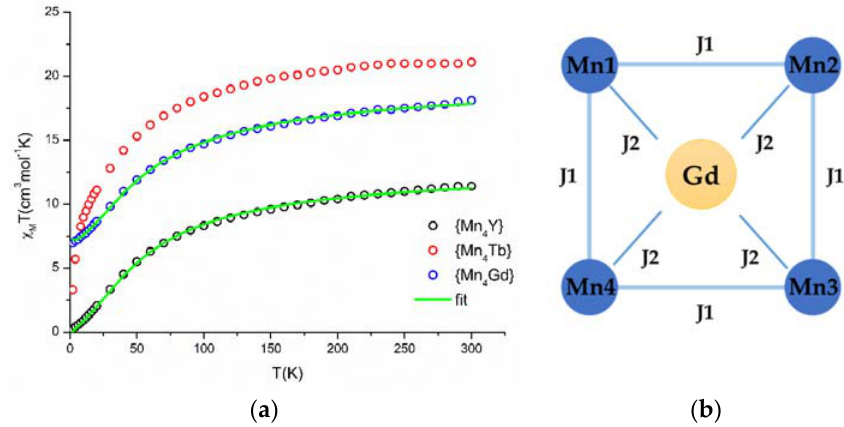
Figure 3. ( a ) Temperature dependence of magnetic susceptibility for complexes 1 , 2 , and 3 . Green solid line represents simulation of the data in complexes 1 and 3 ; see text for details and fitting parameters. ( b ) Fitting model for complex 1